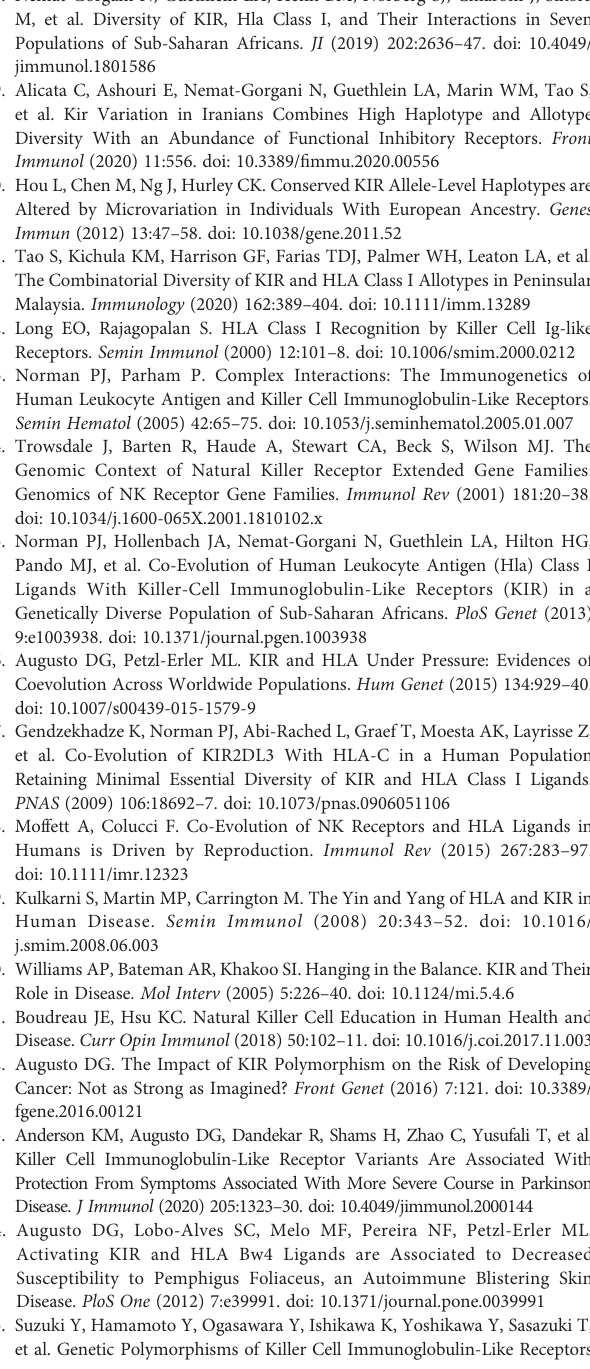
Supplementary Table 2 | High-resolution allelic frequencies of the KIR genes in